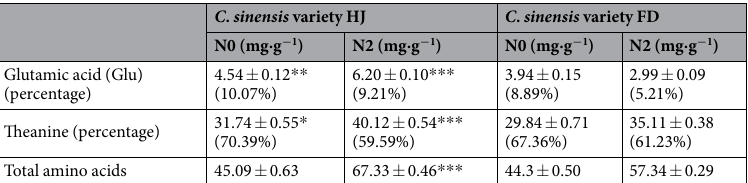
correlated to GS expression in roots, which may be a remote regulation caused by Gln transferring between the roots and leaves.